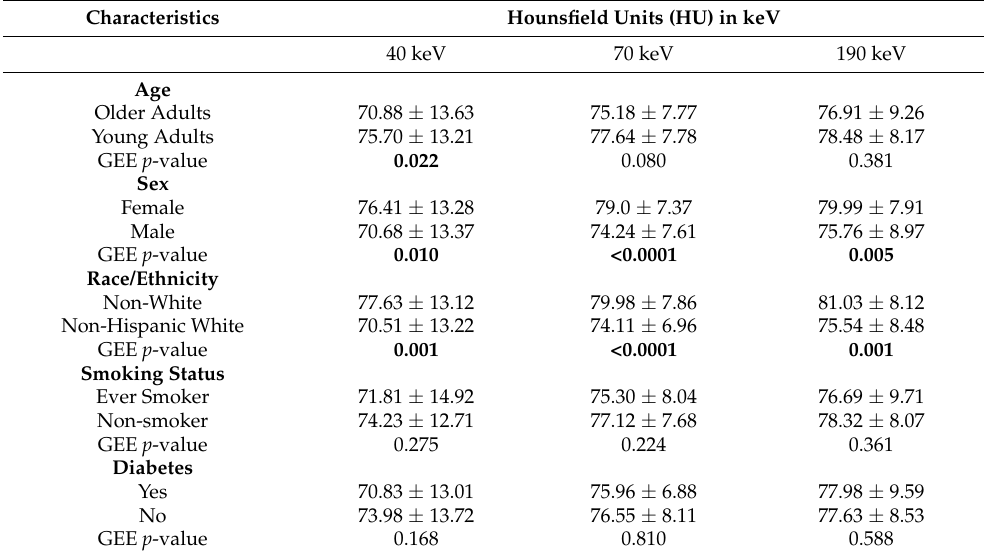
Table 3. Bivariate analysis of clinical and demographic characteristics associated with natural crystalline lens attenuation measured at three energy levels on Dual Energy Computed Tomography (DE-CT) (N = 198 eyes in 103 subjects).